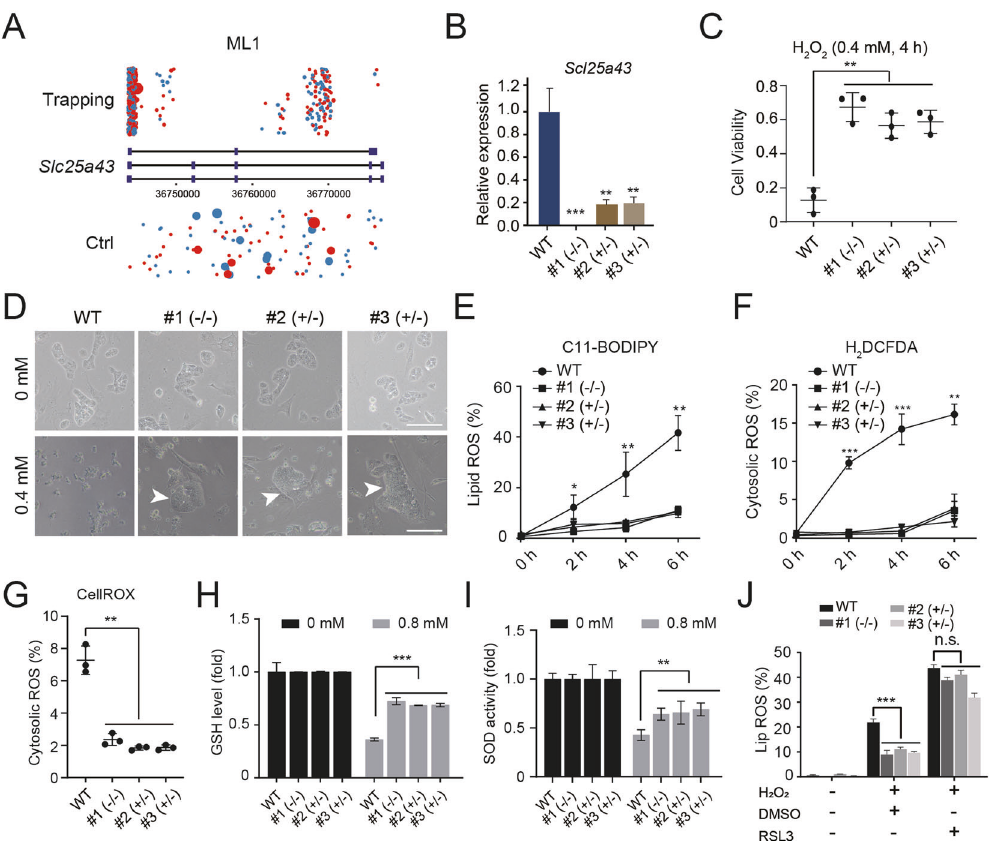
Fig. 3 Validation of Slc25a43 in the oxidative toxicity resistance assay. A Sense (red) and antisense (blue) insertions of Slc25a43 in ML1. The rectangles indicate the exons, and the size of the circle indicates the insertion number. B The expression levels of Slc25a43 in #1 ( − / − ), #2 ( + / − ), #3 ( + / − ) and WT-diESCs by qPCR. Data represented three independent experiments. t- test, ** p < 0. 01, *** p < 0.001. Data were presented as the mean ± SD. C Cell viability of #1 ( − / − ), #2 ( + / − ), #3 ( + / − ) and WT-diESCs treated with 0.4 mM H 2 O 2 for 4 h. Data represented three independent experiments. t- test, ** p < 0.01. Data were presented as the mean ± SD. D Phase-contrast images of #1 ( − / − ), #2 ( + / − ), #3 ( + / − ) and WT-diESCs 4 days after being treated with 0.4 mM H 2 O 2 for 4 h. Scale bar, 100 μ m. E Lipid ROS production in Slc25a43 -KO ESCs and WT-diESCs treated with 0.8 mM H 2 O 2 for 0, 2, 4 and 6 h by fl ow cytometry analysis with C11-BODIPY staining. Data represented three independent experiments. t- test, * p < 0.05, ** p < 0.01. Data were presented as the mean ± SD. F Cytosolic ROS levels in Slc25a43 -KO ESCs